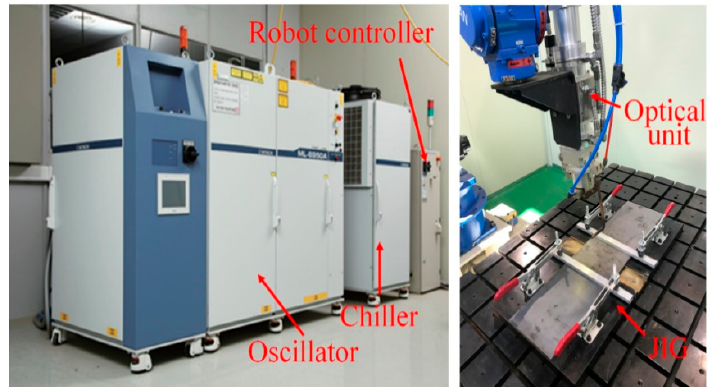
Figure 1. Fiber laser welding equipment.